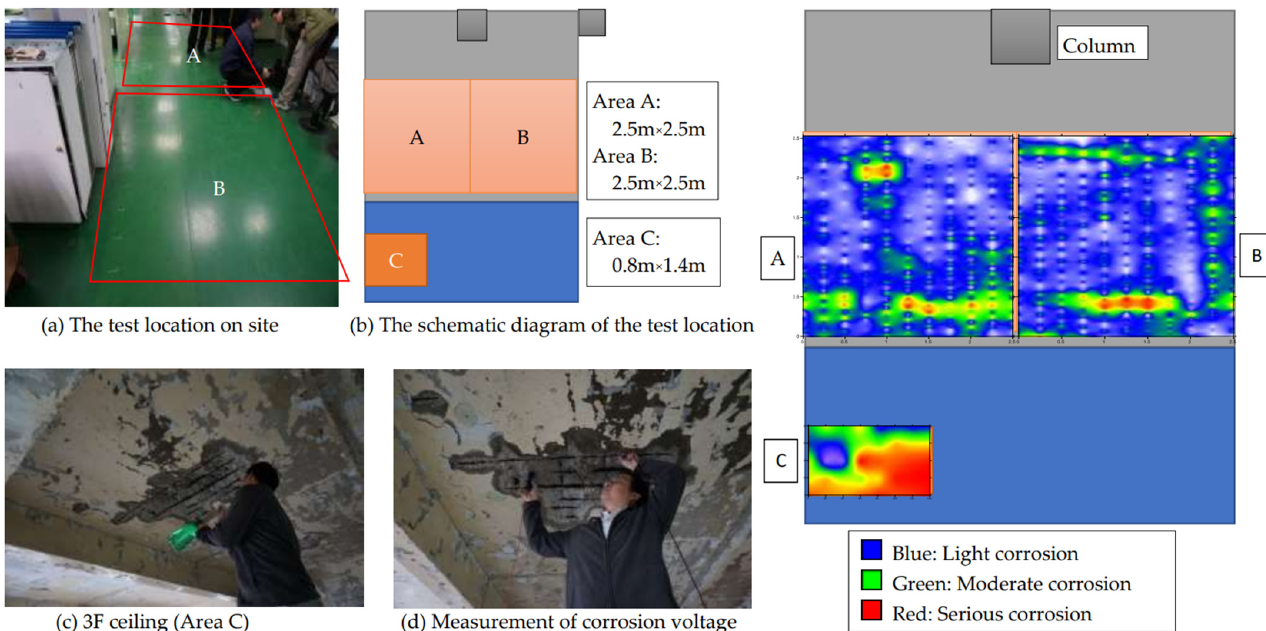
Figure 23. Steel Bar Corrosion in Plate.